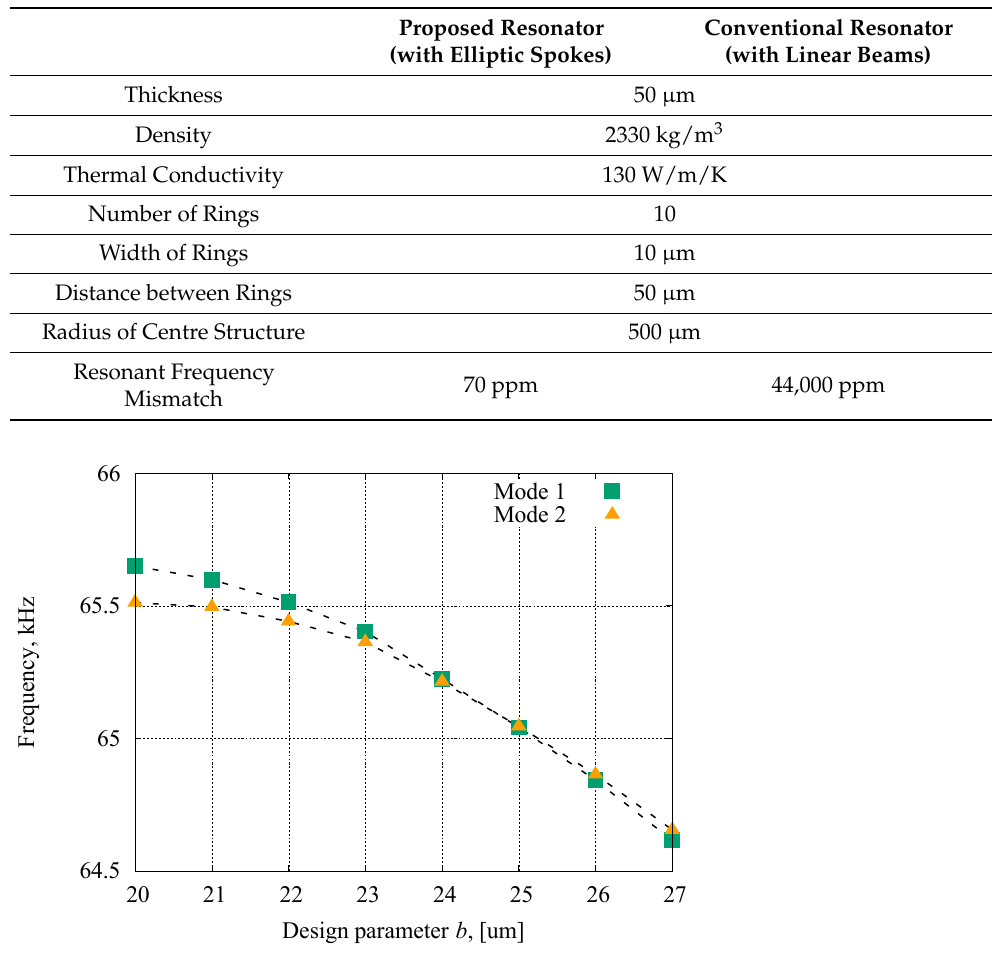
Table 1. Design parameters and simulation results.